Question: Describe this figure in one sentence.
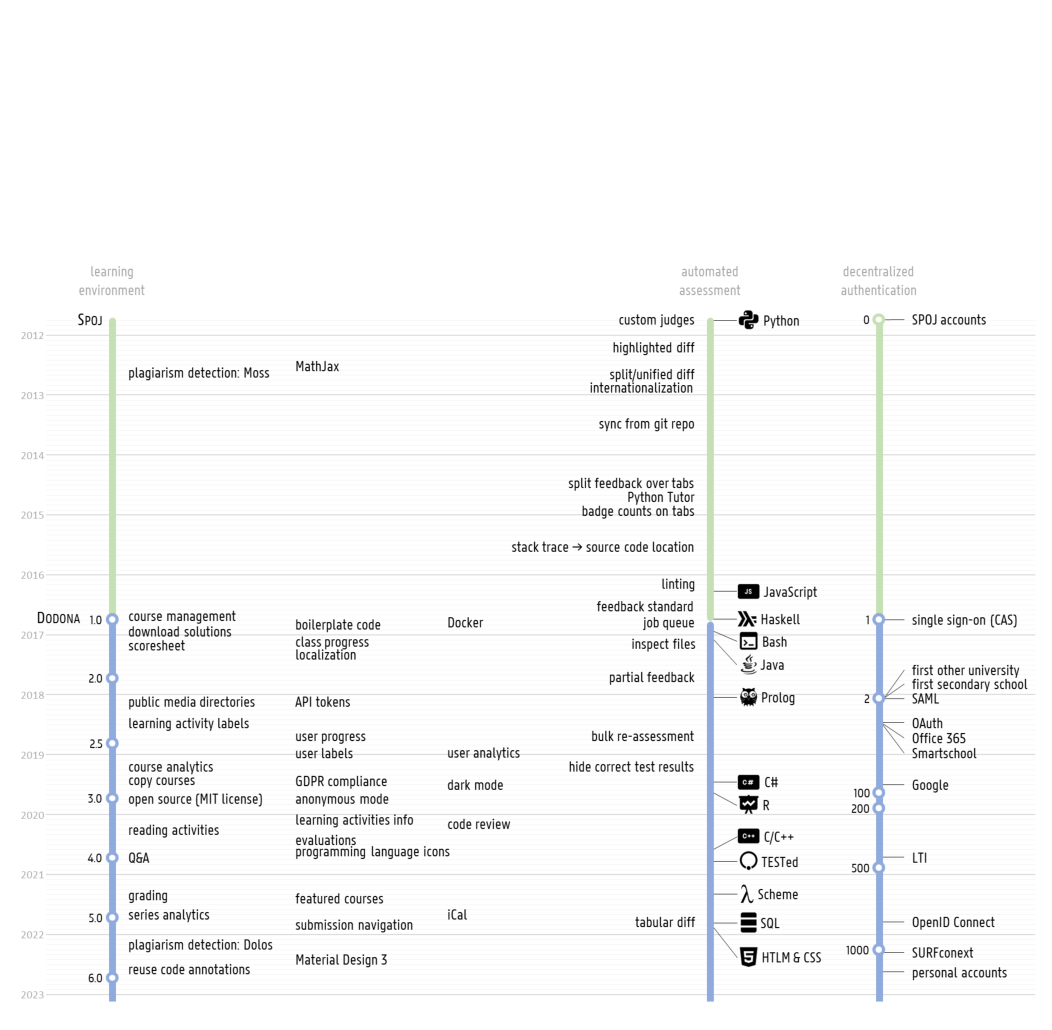
Answer: Historical overview with milestones from running a Python course supported by automated assessment for eleven years and developing Dodona for six years. Vertical positions of labels indicate when milestones were introduced. We used a Python judge in the Sphere Online Judge (SPOJ) to pro- vide automated assessment during the ﬁrst ﬁve years of the course, which was afterwards migrated to Dodona. From left to right: features, judges and authentication-support introduced in SPOJ/Dodona. Numbers to the left of the tracks: major Dodona releases (learning environment), and number of institutions using Dodona (decentralized authentication).